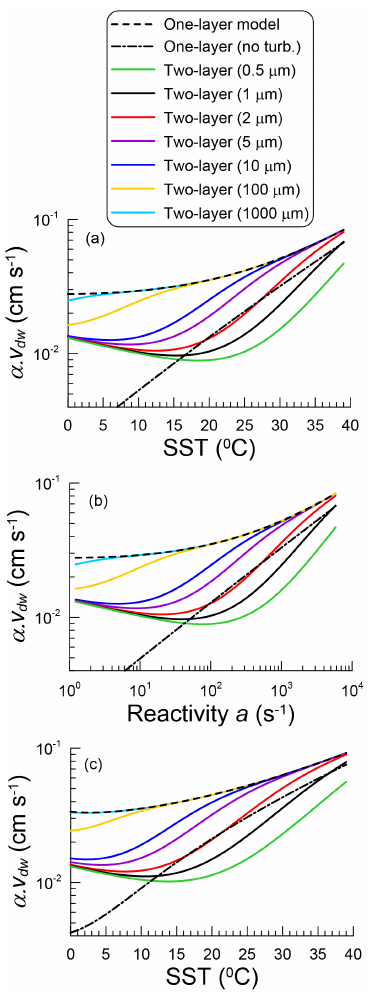
Figure 5. Variation of the oceanic component of ozone dry deposi- tion velocity αv dw ( = 1 /r c ) as a function of (a) sea surface temper- ature (SST, ◦ C) and (b) reactivity a (s − 1 ). Curves obtained using the one-layer reactivity deposition scheme with and without water- side turbulence, and the two-layer reactivity deposition scheme for a range of δ m values. Equation (12) was used for the iodide concentra- tion, and the waterside friction velocity ( u ∗ w ) used was 0.01ms − 1 . Plot (c) is the same as (a) except that Eq. (19) was used for the iodide